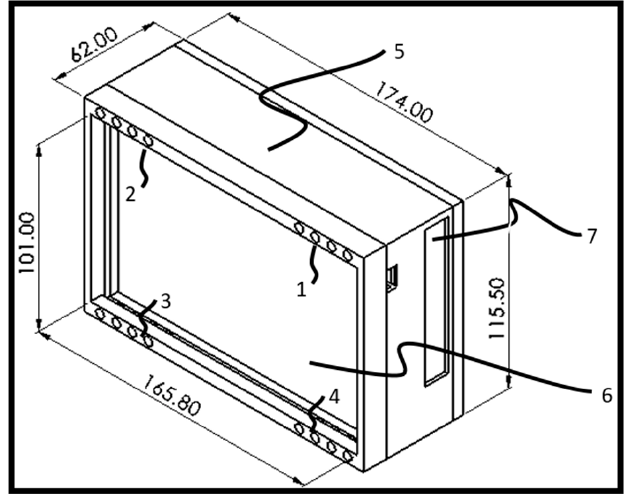
Figure 18. Front part of the SOMN_IA. ( a ) Design of the front part. ( b ) Components used. Figure 18. Design of front part of the